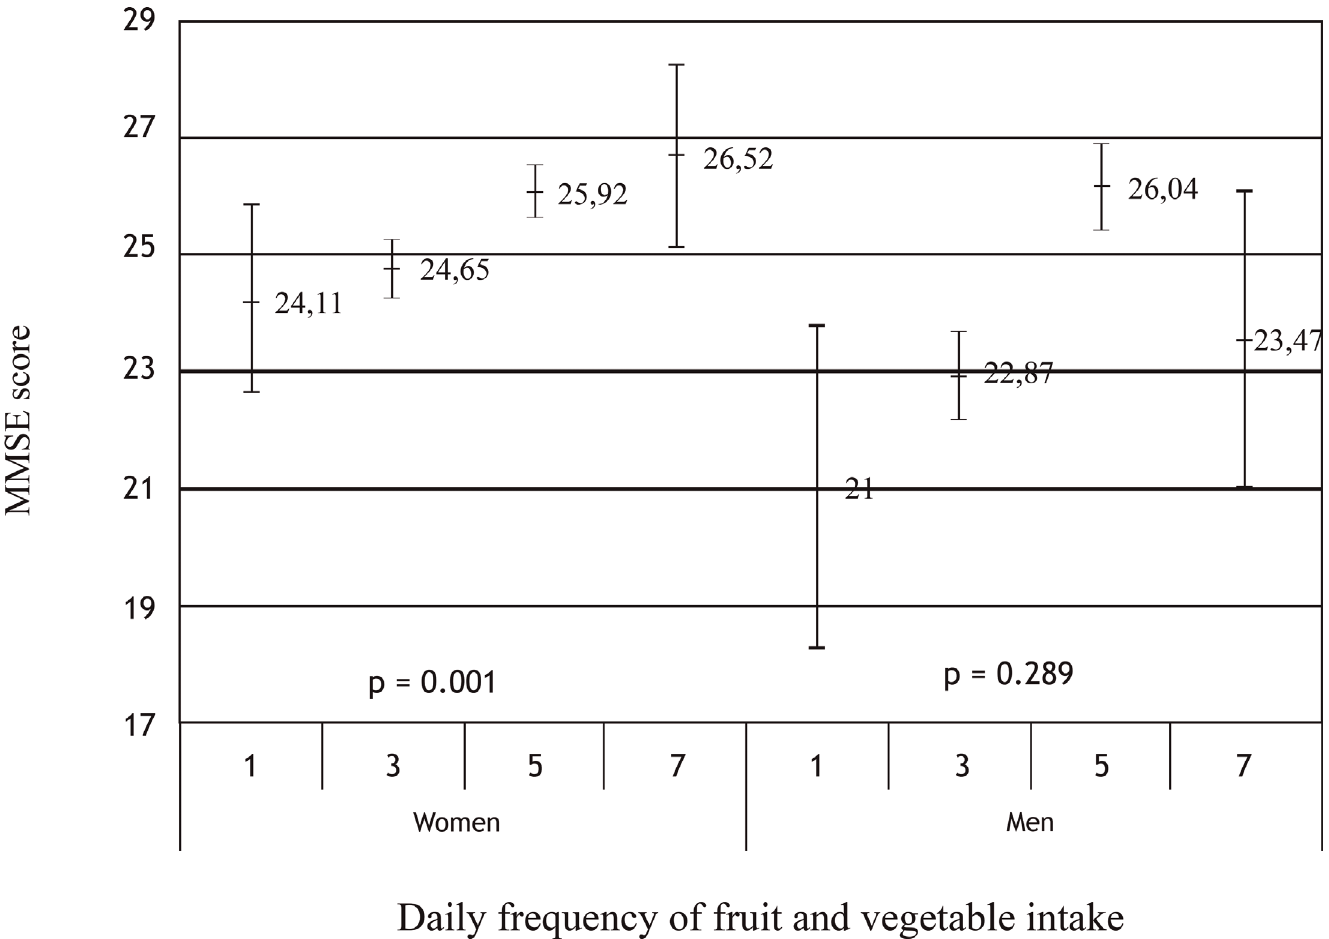
Fig 1. Univariate analysis of MMSE means and confidence intervals according to the daily frequency of fruit and vegetable intake for both genders.